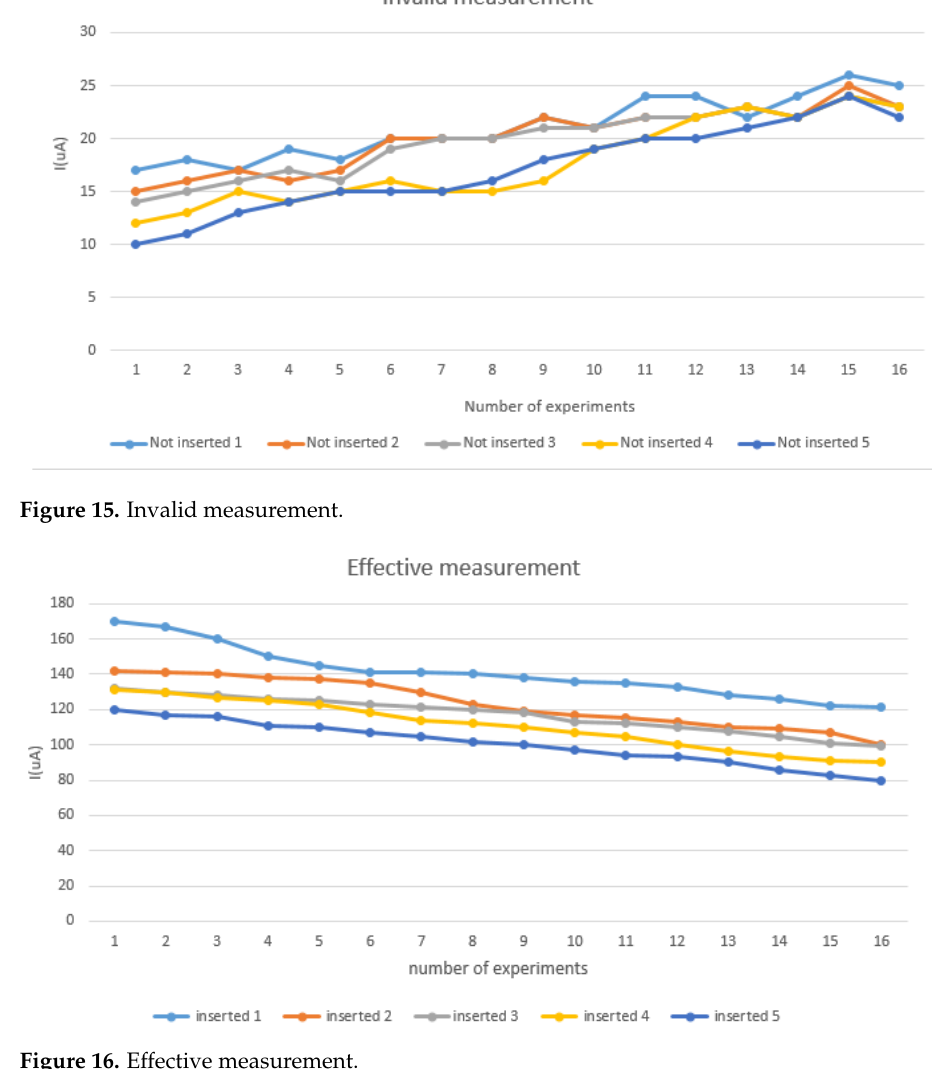
Figure 16. Effective measurement.